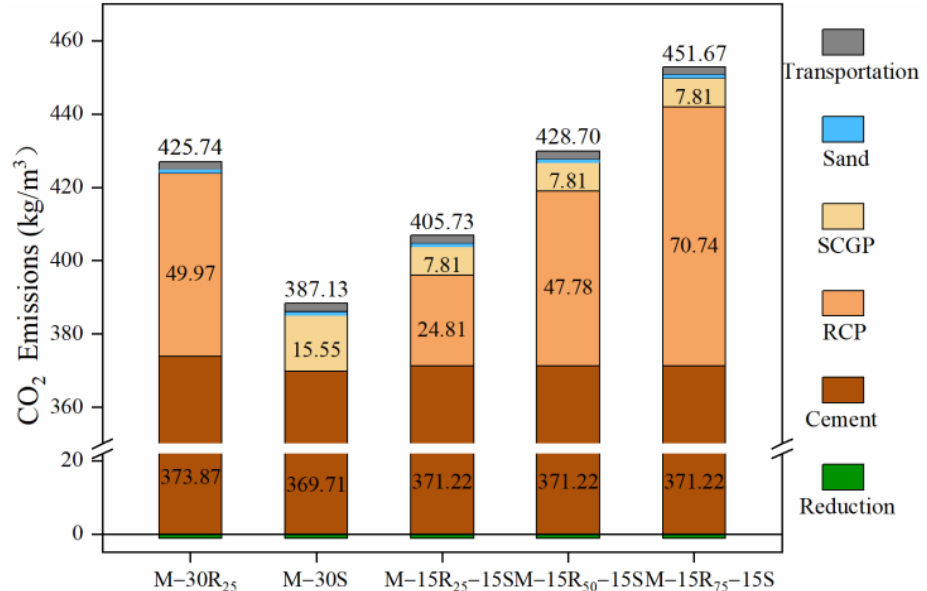
Figure 7. CO 2 emission from all eco-efficient mortar mixtures.